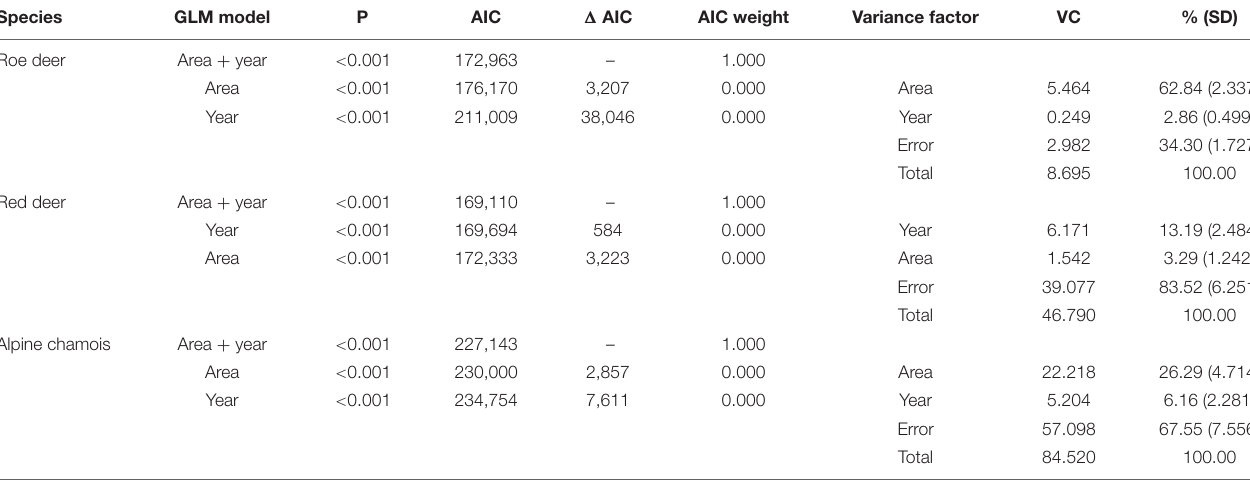
TABLE 3 | GLM models of body mass loss ranking and evaluation and variance components analysis.